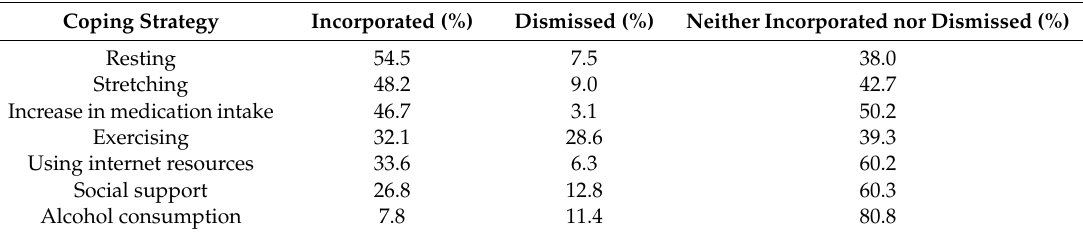
Table 4. Changes in coping strategies during lockdown.